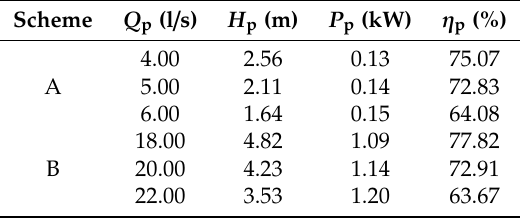
Table 2. Influences of di ff erent connection way on the external parameters of the pump.